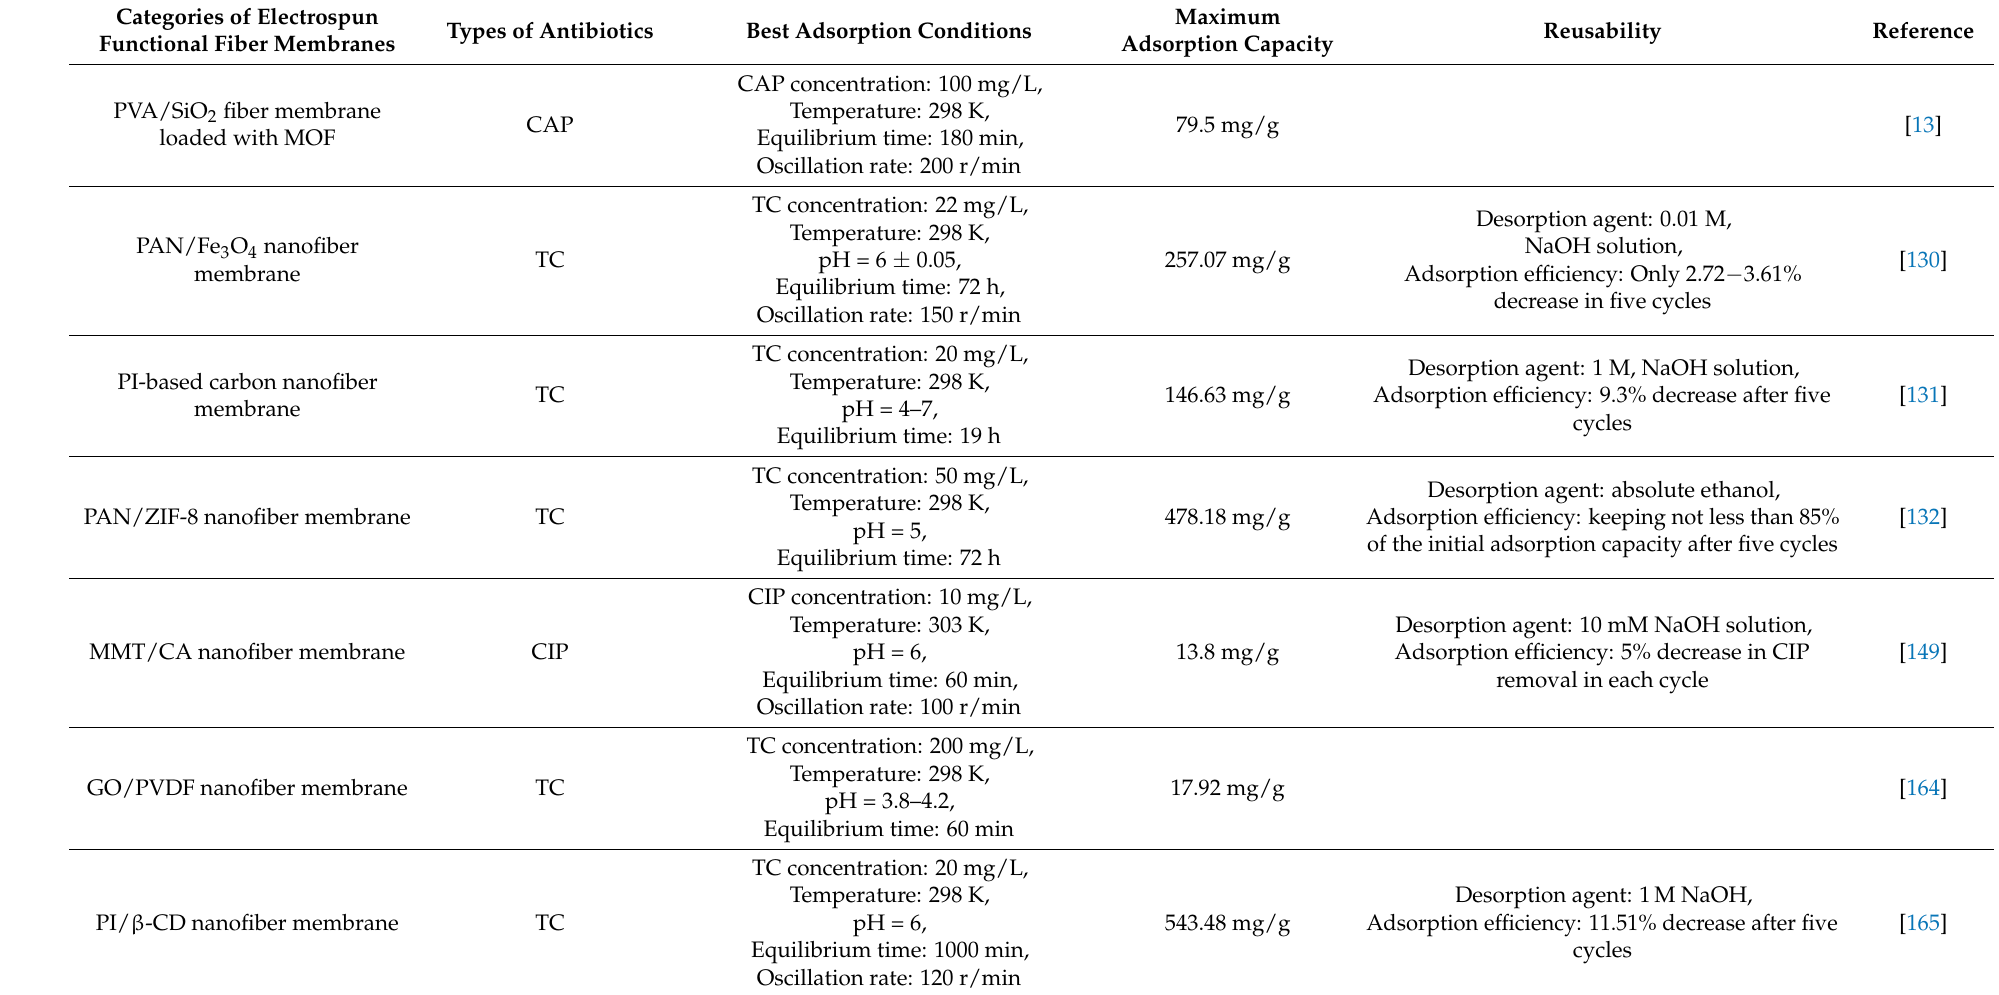
Table 4. Comparison of adsorption conditions and effects of different electrospun functional fiber membranes on various